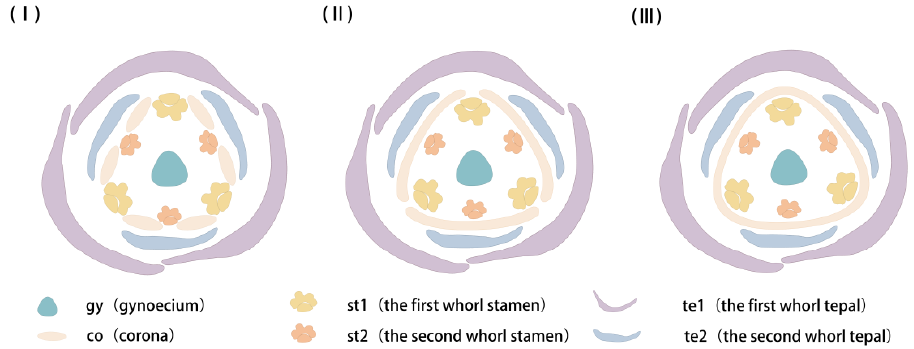
Figure 9. Development model of the JZ corona. te1 and te2 denote the first and second whorls of tepals, respectively, st1 and st2 denote the first and second whorls of stamens, respectively, gy denotes gynoecium, the yellow patterning denotes the corona in morphogenesis, and ( I – III ) denote the three stages of corona